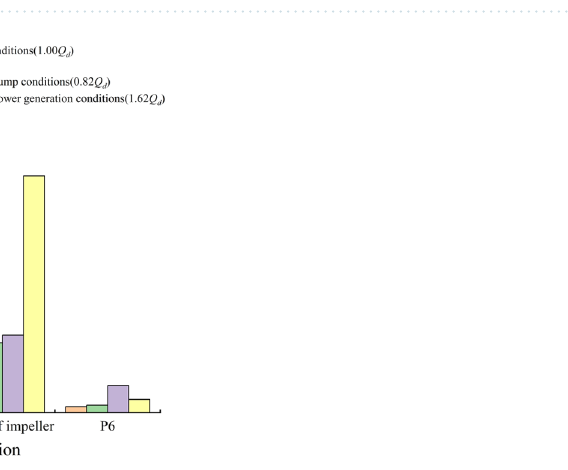
Figure 17. Peak-to-peak value of pressure pulsation under special utilization conditions.